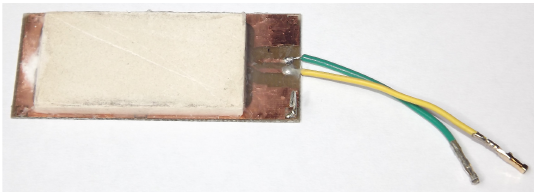
Figure 3. Photograph of the fabricated sensor.